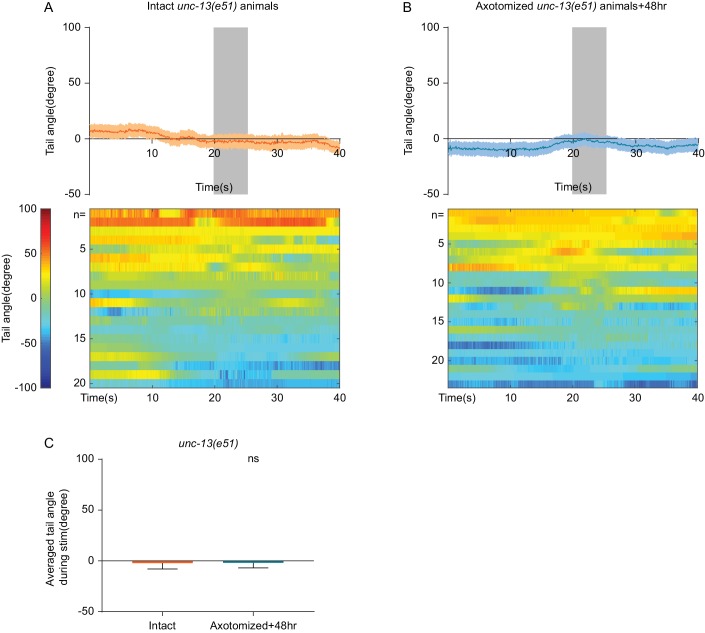
Optogenetically-triggered tail-bending behavior depends on synaptic transmission.(A) Tail-bending behavior of intact unc-13(e51) animals (2-day-old adults). (B) Tail-bending behavior of unc-13(e51) animals 48 hr after axotomy. (C) Averaged tail angle during stimulation of both intact and axotomized unc-13(e51) animals in (A) and (B). ns, not significant. Unpaired t test.